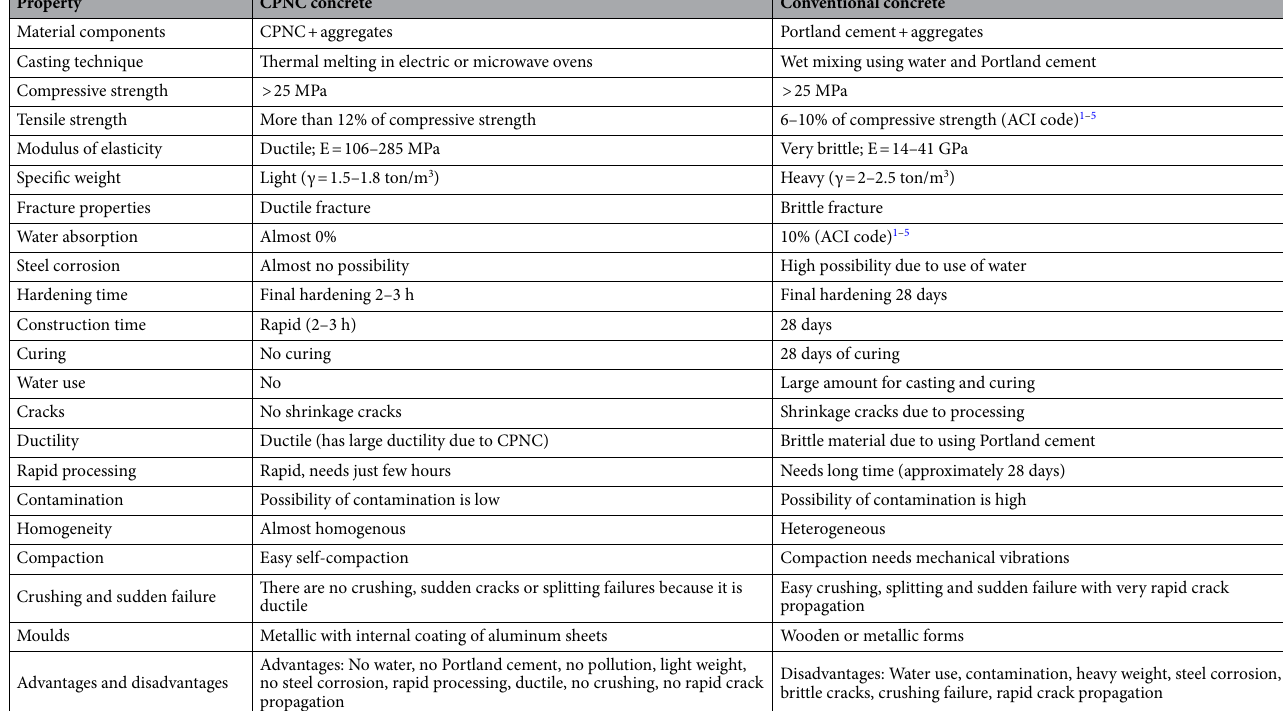
Table 6. Comparison between CPNC concrete and Portland cement